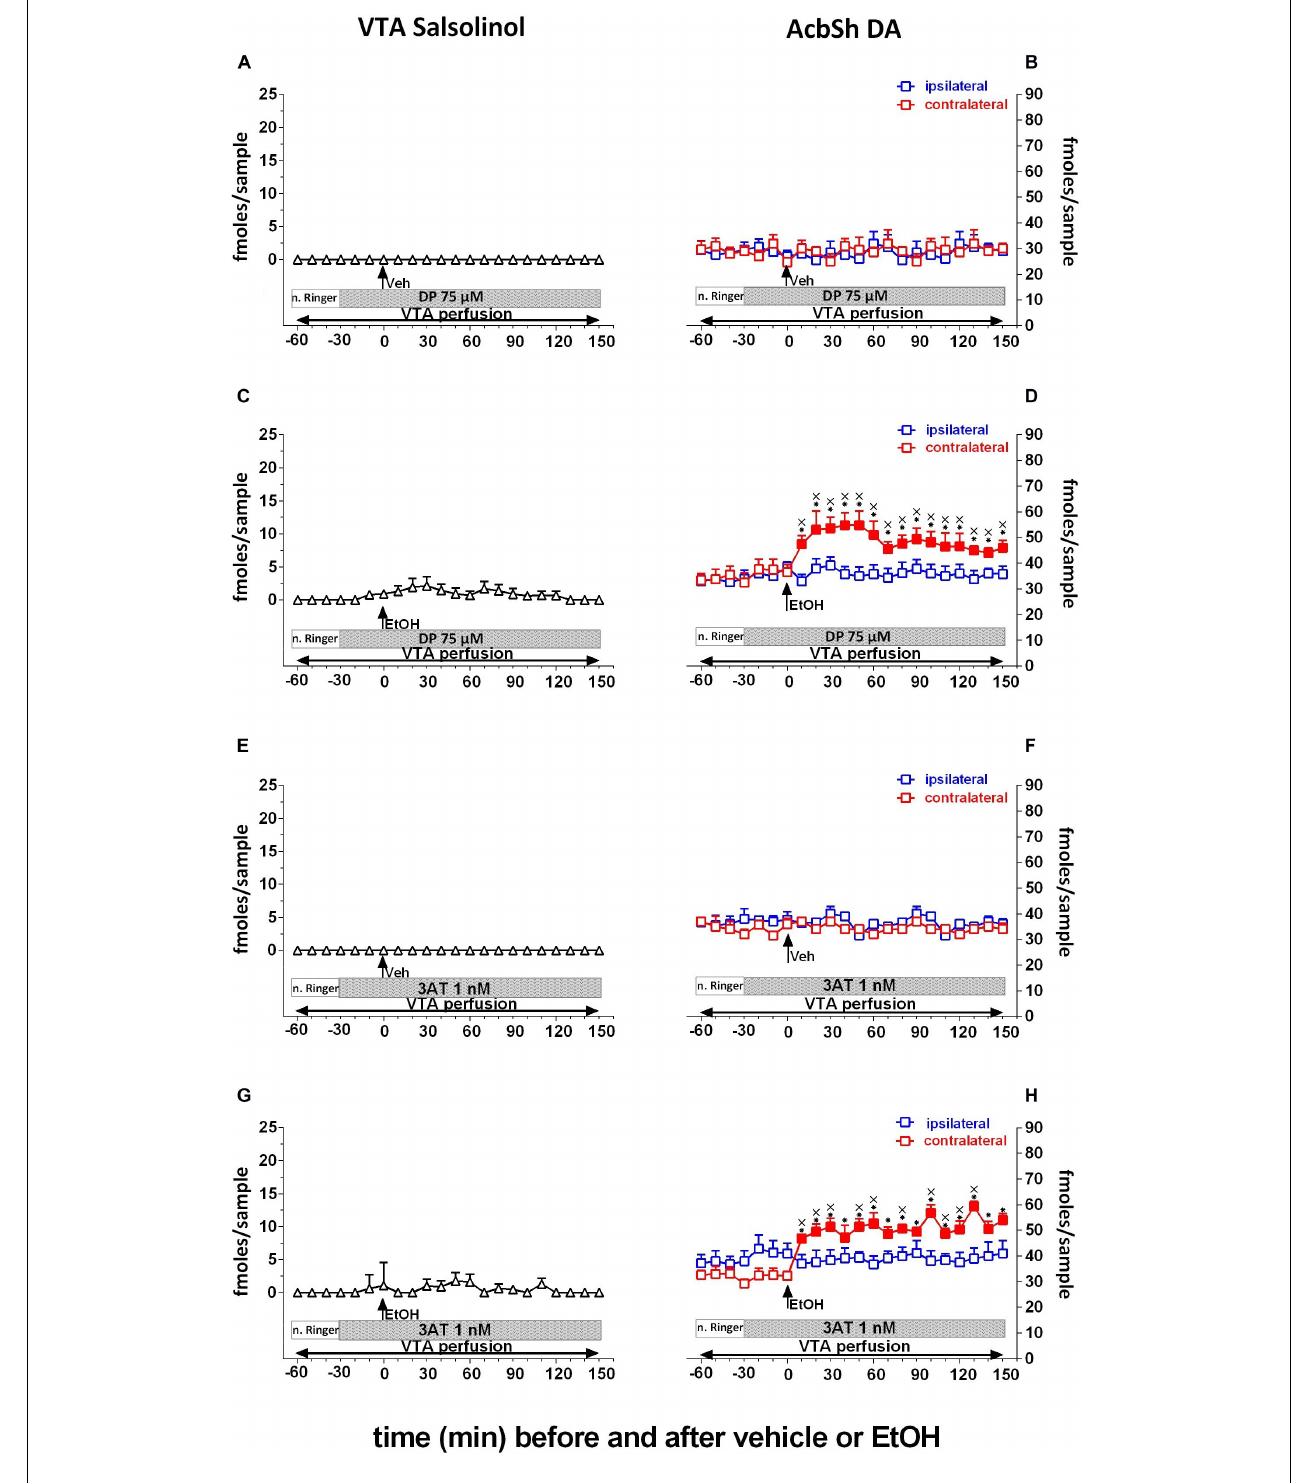
FIGURE 4 | Effects of intragastric administration of vehicle (tap water, 10 ml/kg) [ (A) N = 6, (B) N = 8, (E) N = 6, (F) N = 8] or ethanol (EtOH) (1 g/kg, 20% v/v) [ (C) N = 11, (D) N = 8, (G) N = 11, (H) N = 9] in the presence of reverse dialysis application in the pVTA, beginning 30 min before EtOH administration, of D-penicillamine (DP) (75 µ M) (A–D) or 3-amino-1,2,4-triazole (3AT) (1 nM) (E–H) on pVTA salsolinol (A,C,E,G) and on ipsilateral and contralateral AcbSh DA (B,D,F,H) dialysates. Horizontal bars depict the contents of the pVTA perfusion fluid along the experiments. Vertical arrows indicate the last pVTA or AcbSh microdialysis sample before vehicle or EtOH administration. Filled symbols indicate samples representing p < 0.001 vs. basal; ∗ p < 0.01 vs. vehicle administration; x p < 0.01 vs. ipsilateral area.